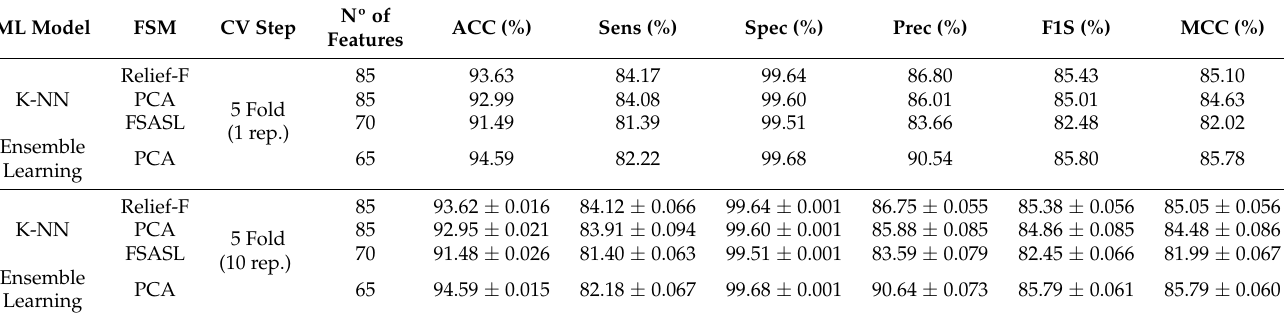
Table 8. Comparison of the best classification results (ACC, Sens, Spec, Prec, F1S, MCC), attained after the 5-1 and 5-10 k-fold cross-validation steps for the K-NN and Ensemble Learning